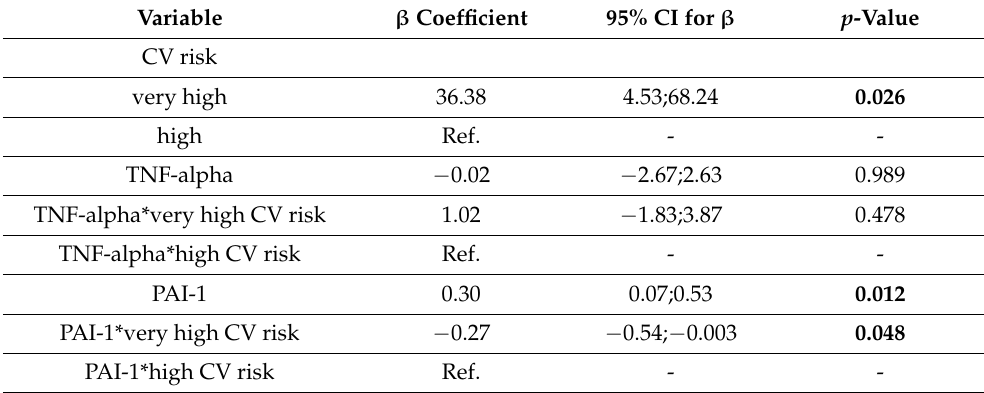
Table 3. General Linear Model parameter estimates for the relationship between resistin concentration (ng/mL) and CV risk level, TNF-alpha and PAI-1 concentrations in CKD patients. Variable